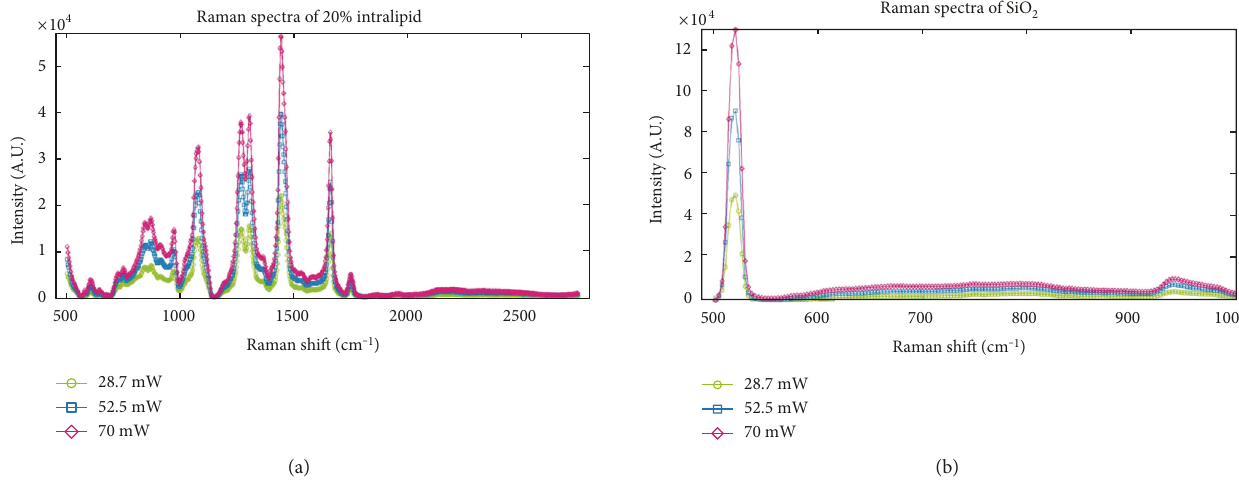
Figure 2: (a) Spectra of 20% intralipid solution after auto fl uorescence suppression and (b) spectra of a silicon wafer (SiO laser optical powers of 28.7mW (empty diamond, magenta), 52.5mW (empty square, blue), and 70mW (empty circle, green). No peak shift or spectral change was observed from power